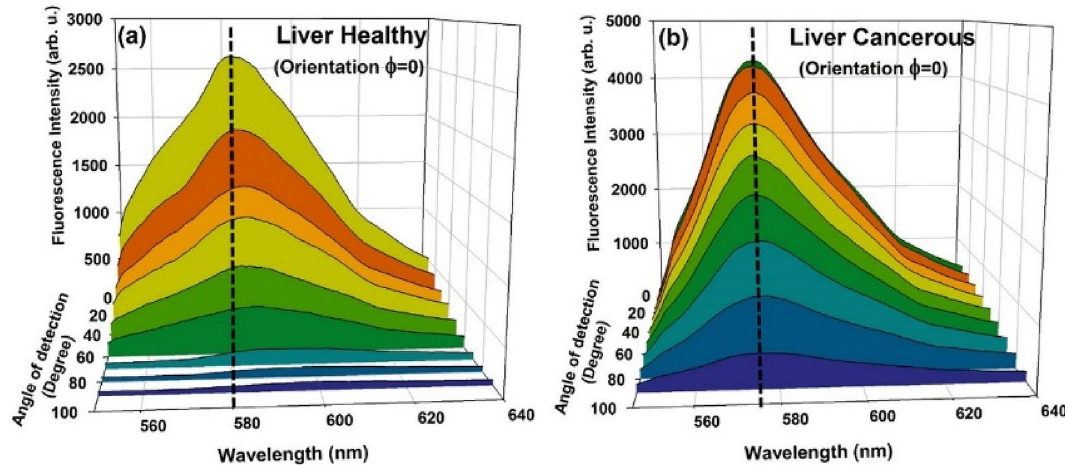
Figure 5. LIF spectra detected at θ = 10°–90° due to excitation of stained ( a ) healthy and ( b ) cancerous liver tissues. Tissue is oriented at ϕ =